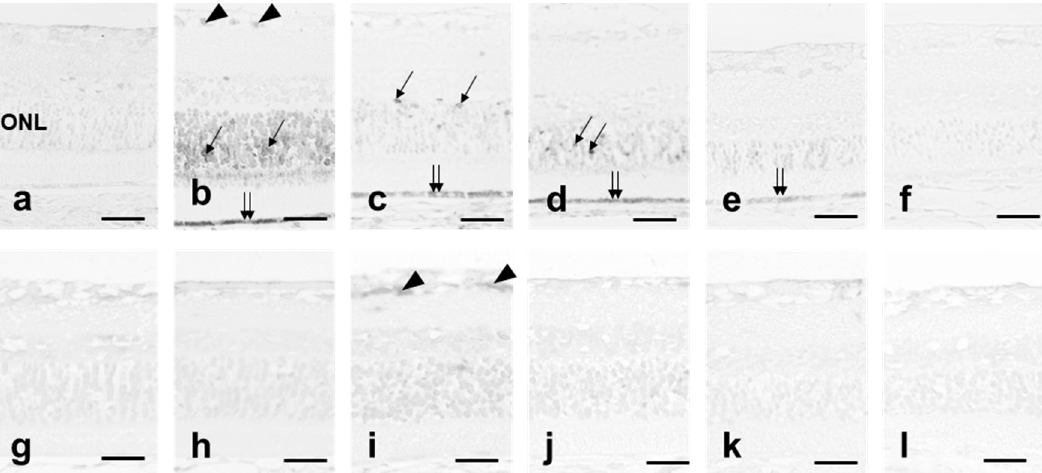
Figure 4. Expression of 8-hydroxy-deoxyguanosine (8-OHdG). Superior retinal samples obtained 500 µ m from the optic nerve are seen. ( a – f ) In quercetin ( − ) retina, many cells in the ONL (arrows), ganglion cells (arrowheads), and retinal pigment epithelium (RPE) cells (double arrows) have evidence of oxidative stress resulting from light exposure. ( g – l ) The quercetin ( + ) retinas have mild oxidative stress. ( a , g ) Unexposed retinas; ( b , h ) retinas exposed to light for 12 h; ( c , i ) retinas exposed to light for 24 h; ( d , j ) 1 day after light exposure; ( e , k ) 3 days after light exposure; and ( f , l ) 7 days after light exposure. Bar = 25 µ m. n = 6 in each group.